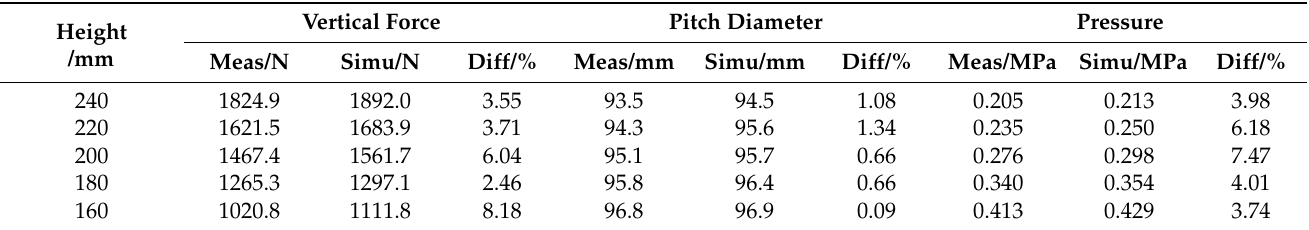
Table 3. The differences between the measured and simulated results.